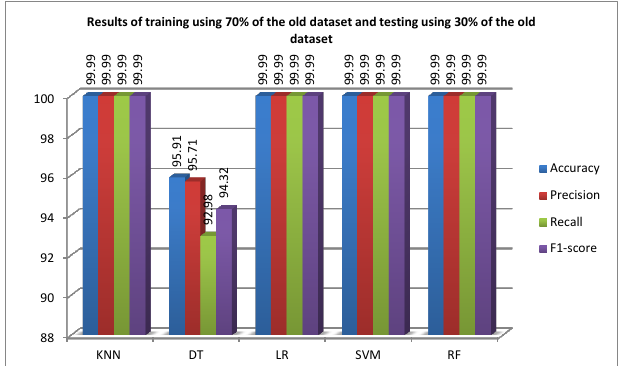
Figure 6. The performance of supervised machine learning algorithms trained on 100% of the old dataset and tested on 100% of the new dataset.